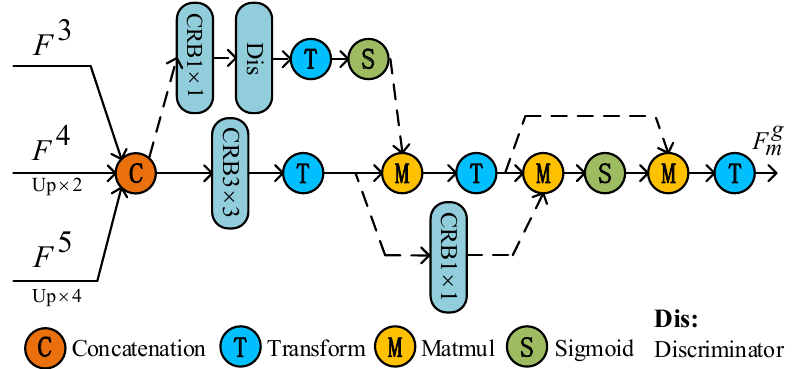
Figure 3. Illustration of semantic guided decoder